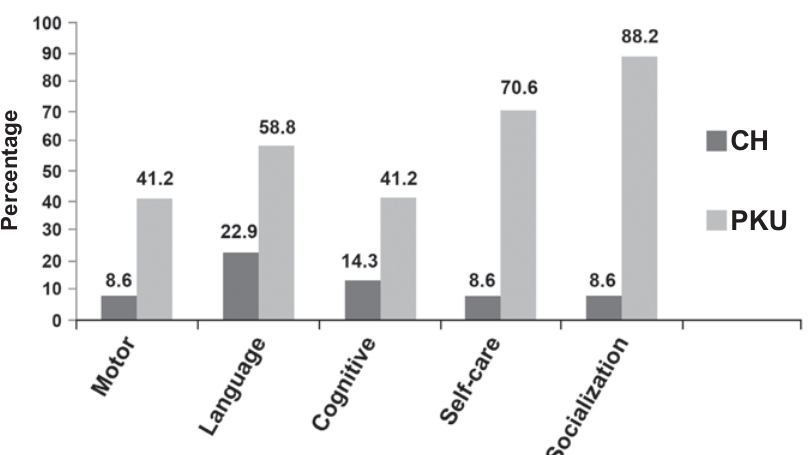
Figure 2- Percentage of children with alterations in the abilities of the